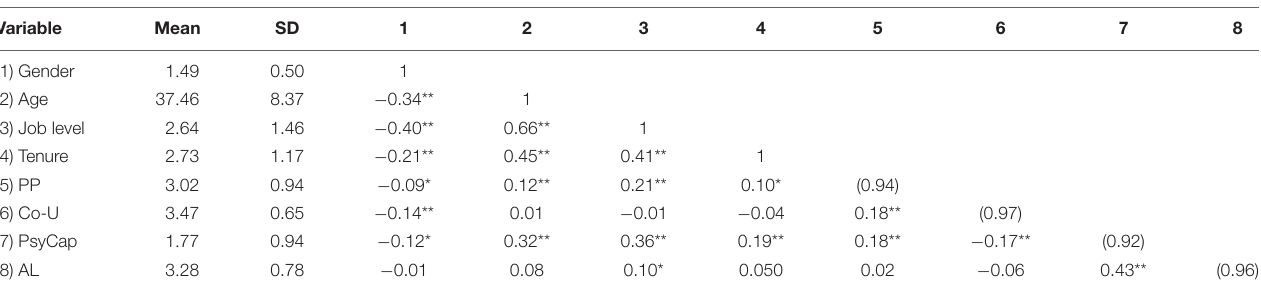
TABLE 2 | Means, standard deviations, correlations, and